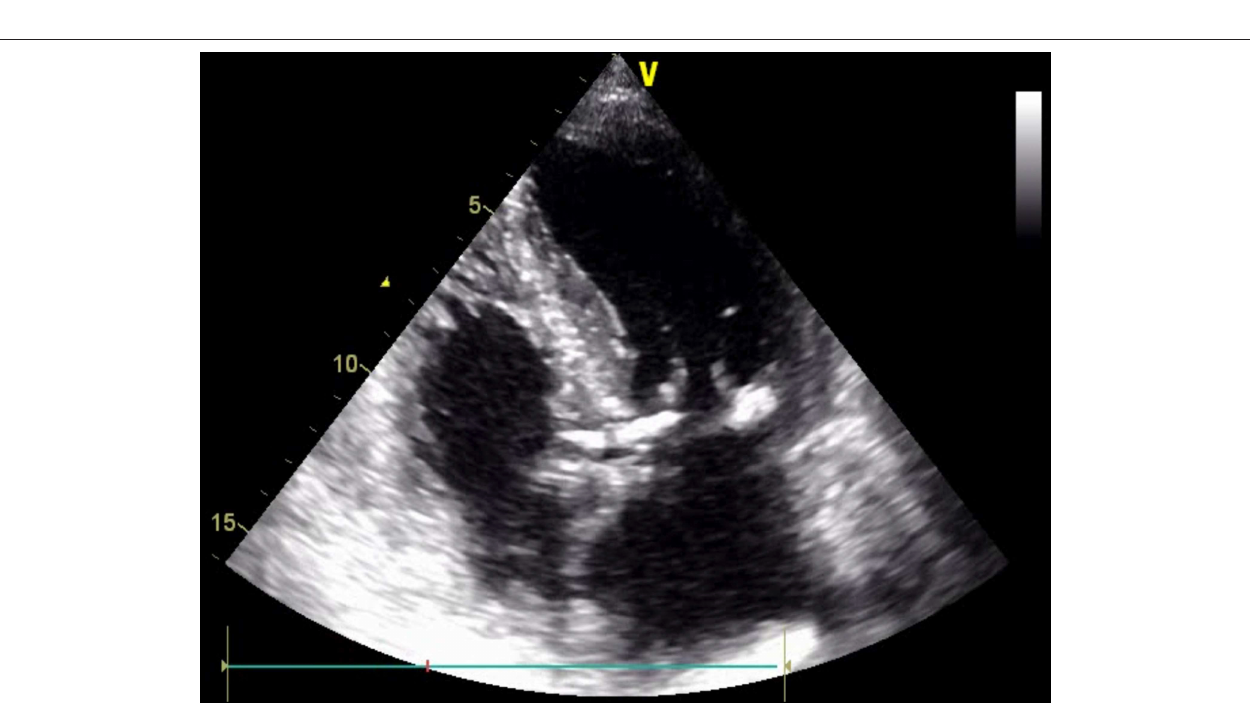
FIGURE 10 | Transthoracic echocardiography (TTE); apical 4-CH view. Mitral annular calcification